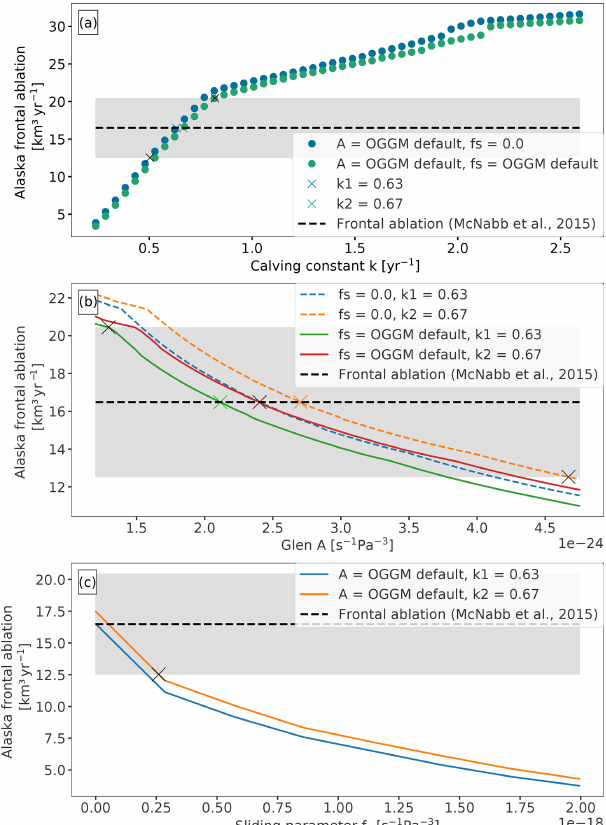
Figure 7. Total frontal ablation of Alaska marine-terminating glaciers computed with varying OGGM parameters. The dashed dark line indicates the Alaska regional frontal ablation calculated by McNabb et al. (2015); light grey shading indicates the standard errors as provided in the study. (a) Sensitivity on calving constant of proportionality ( k ). (b) Sensitivity on Glen’s A parameter, the dashed coloured lines represent zero sliding. (c) Sensitivity on slid- ing parameter ( f s ). Crosses in all plots represent the intercepts be- tween OGGM frontal ablation estimates and McNabb et al. (2015). Note the different y axis